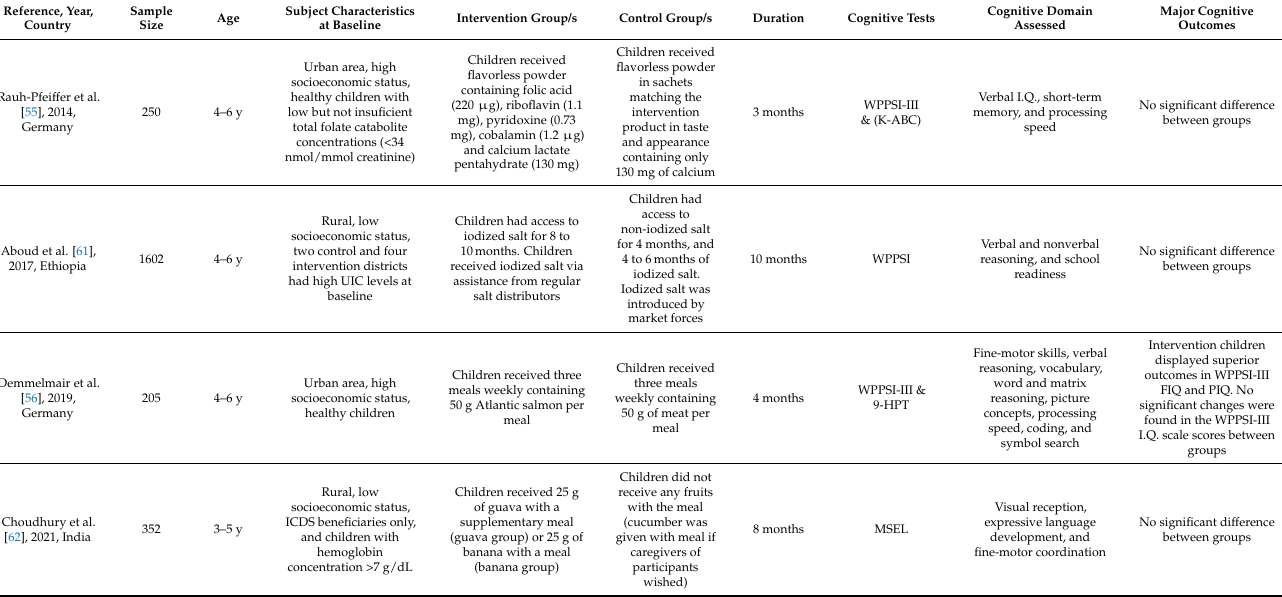
Table 2. Overview of the twelve RCTs exploring the effects of nutritional interventions on the cognitive development of preschool age